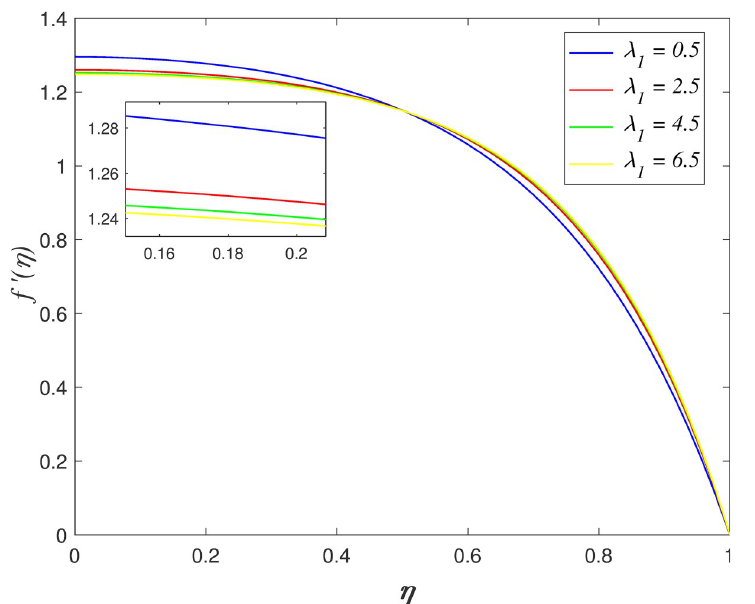
Fig 7. Impact of λ 1 on axial